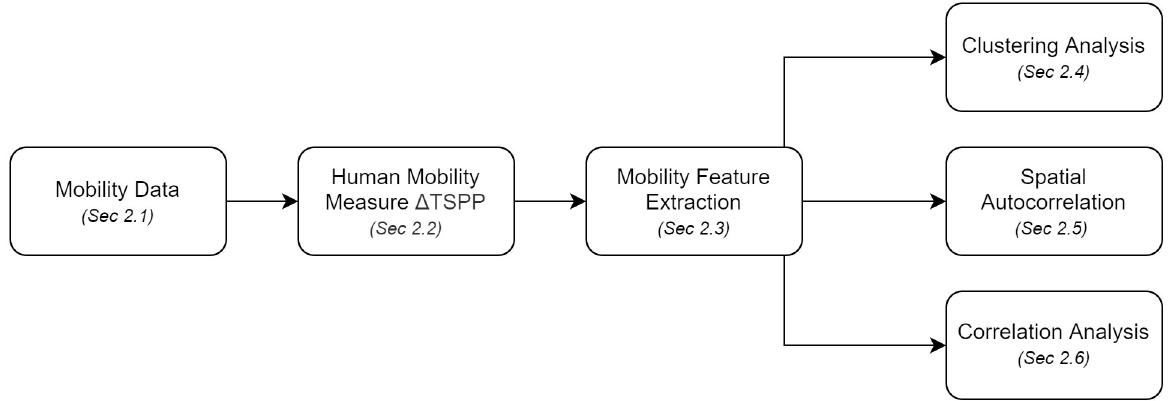
Fig 1. Overview of